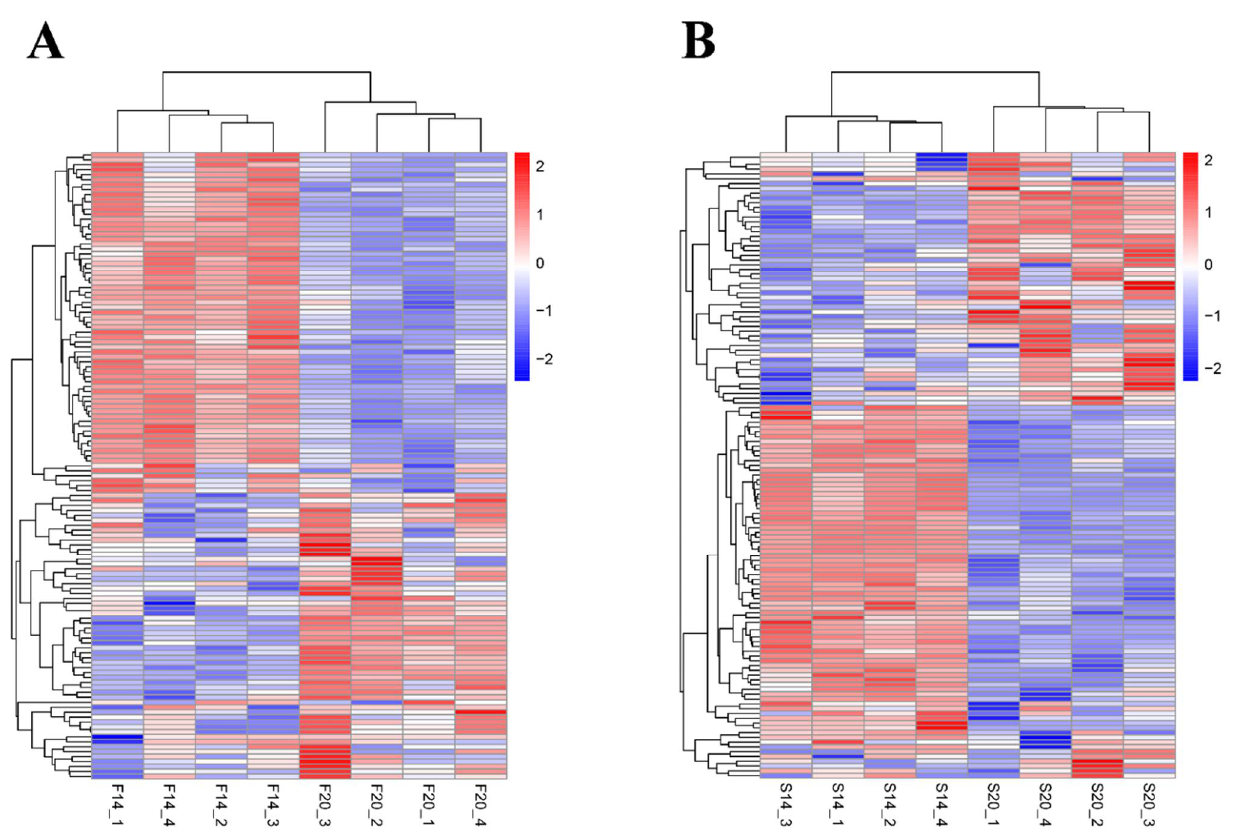
Figure 4. Cluster analysis of DEMs. ( A ) Cluster analysis of F14 vs. F20 comparison group; ( B ) cluster analysis of S14 vs. S20 comparison groups.